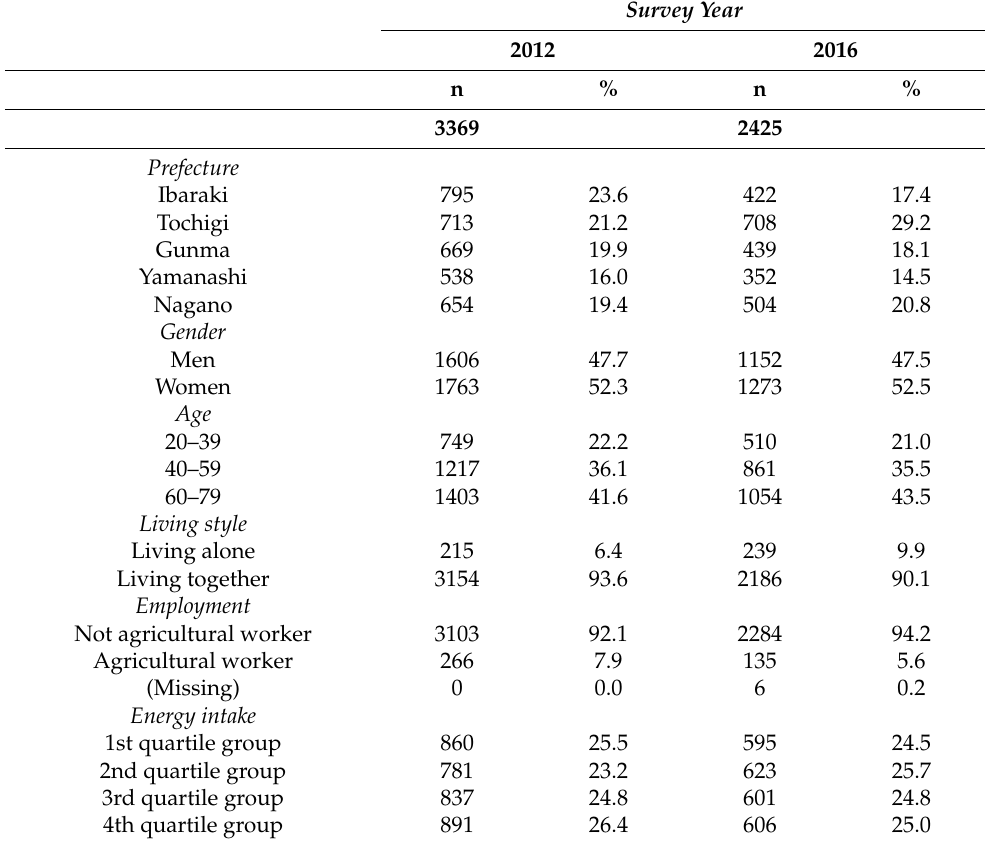
Table 1. Information of subjects among Kanto